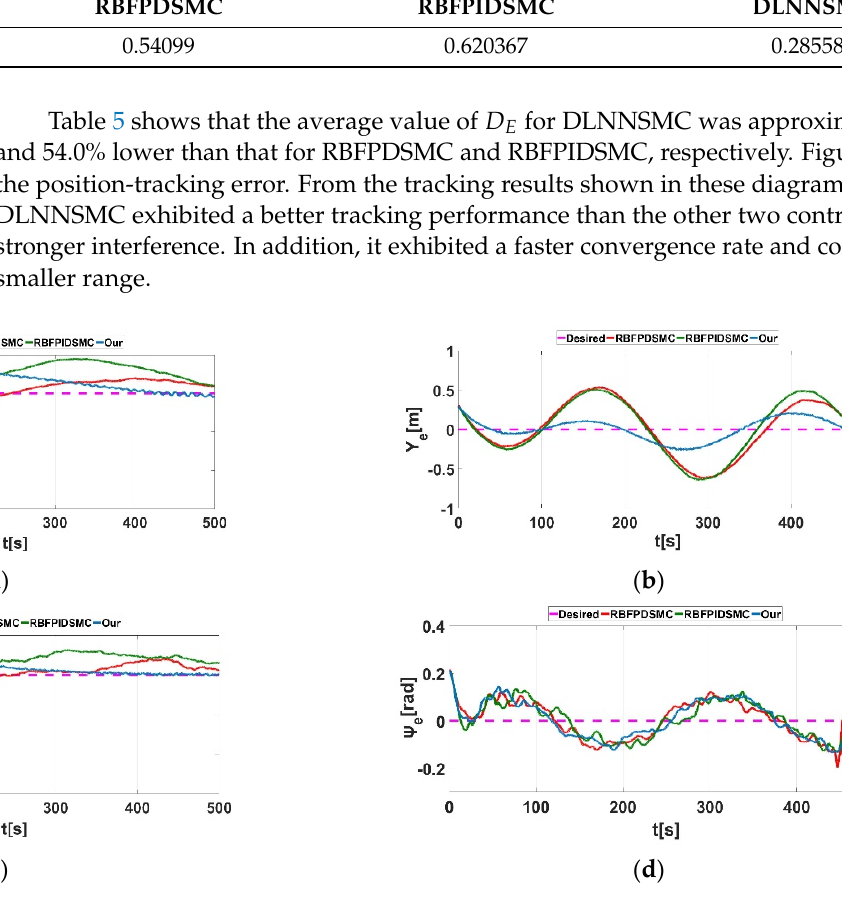
Figure 17. AUV position − tracking errors. ( a ) x e ; ( b ) y e ; ( c ) z e ; ( d ) ψ e Table 5. Average values of 𝐷 𝐸 .